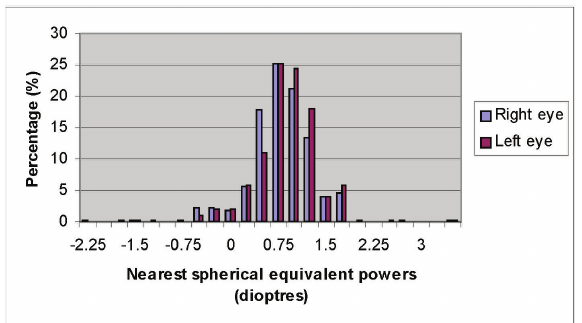
Figure 1 Frequency distribution of the nearest spherical equiv- alent powers (F NSE ) among the subjects. The graph peaks at 25% and most of the powers were between +0.75 and +1.75 D.